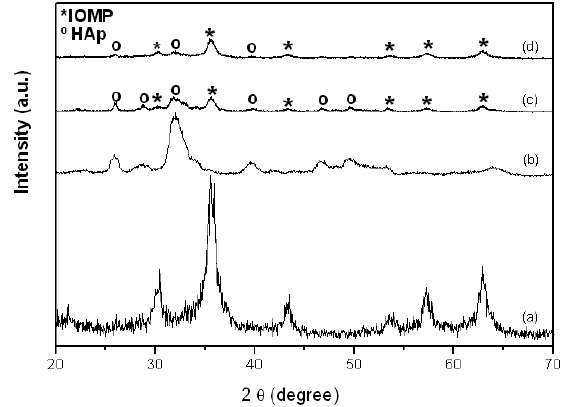
Fig. 1 – The X-ray diffraction powder patterns: (a) IOMP; (b) HAp;